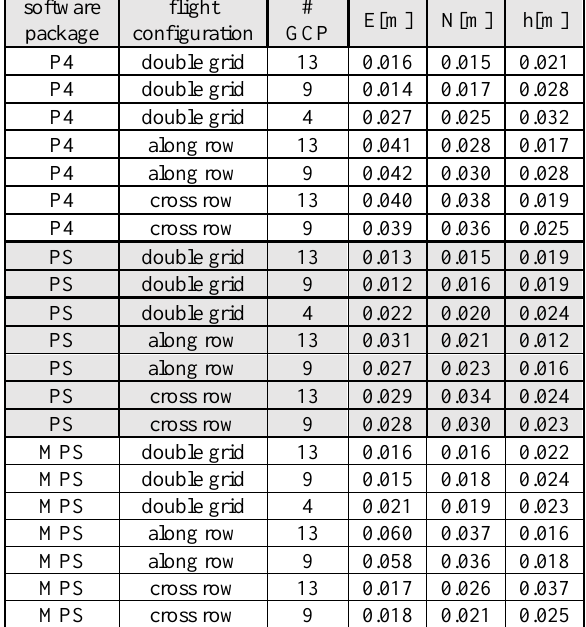
Table 1. Residuals on the CPs after bundle block